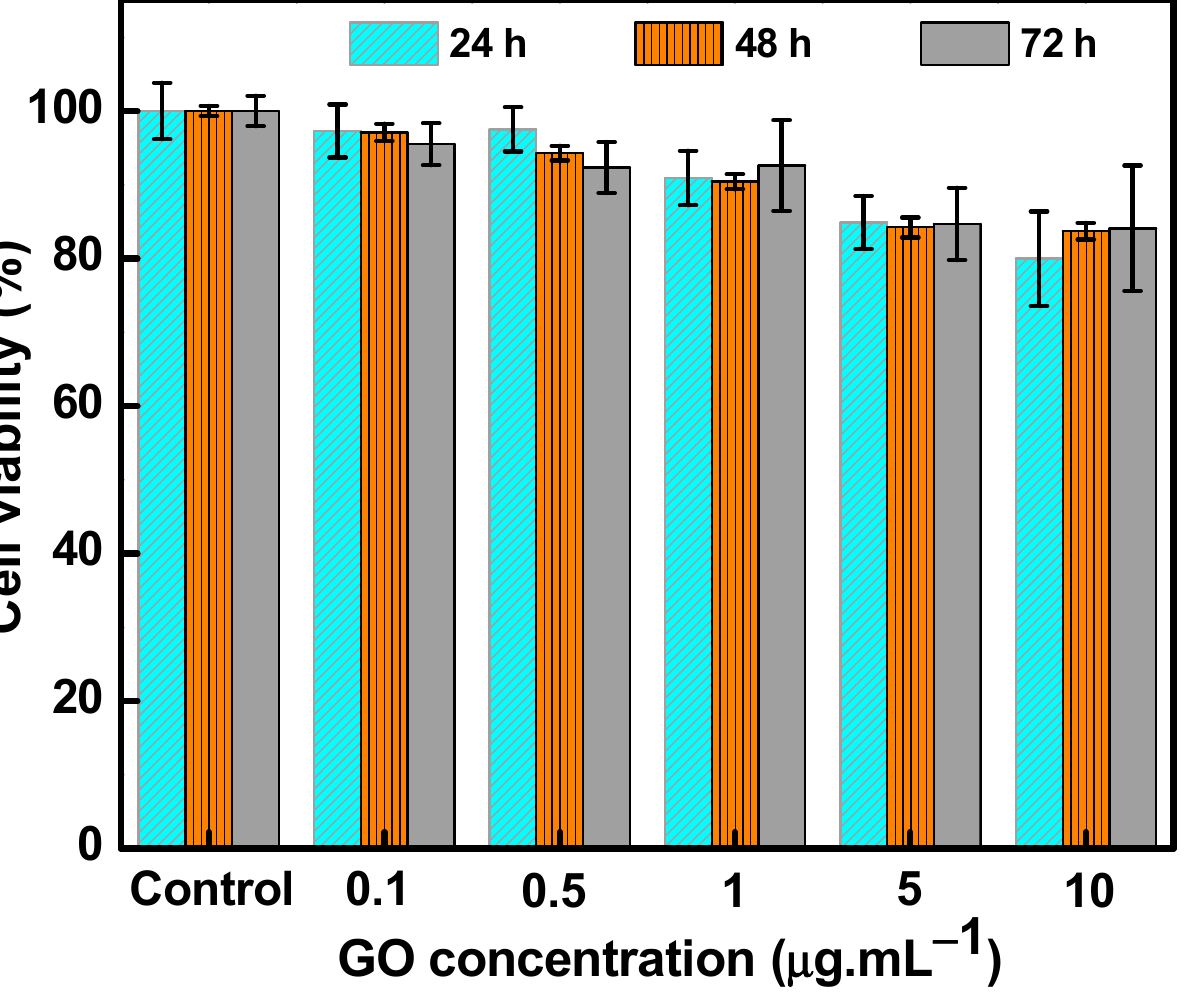
Figure 4. Cell viability of GO-treated NPC-BM1 cells at different GO concentrations at 24, 48, and 72 h. The error bars are standard deviations from triplicate (n = 3) measurements.